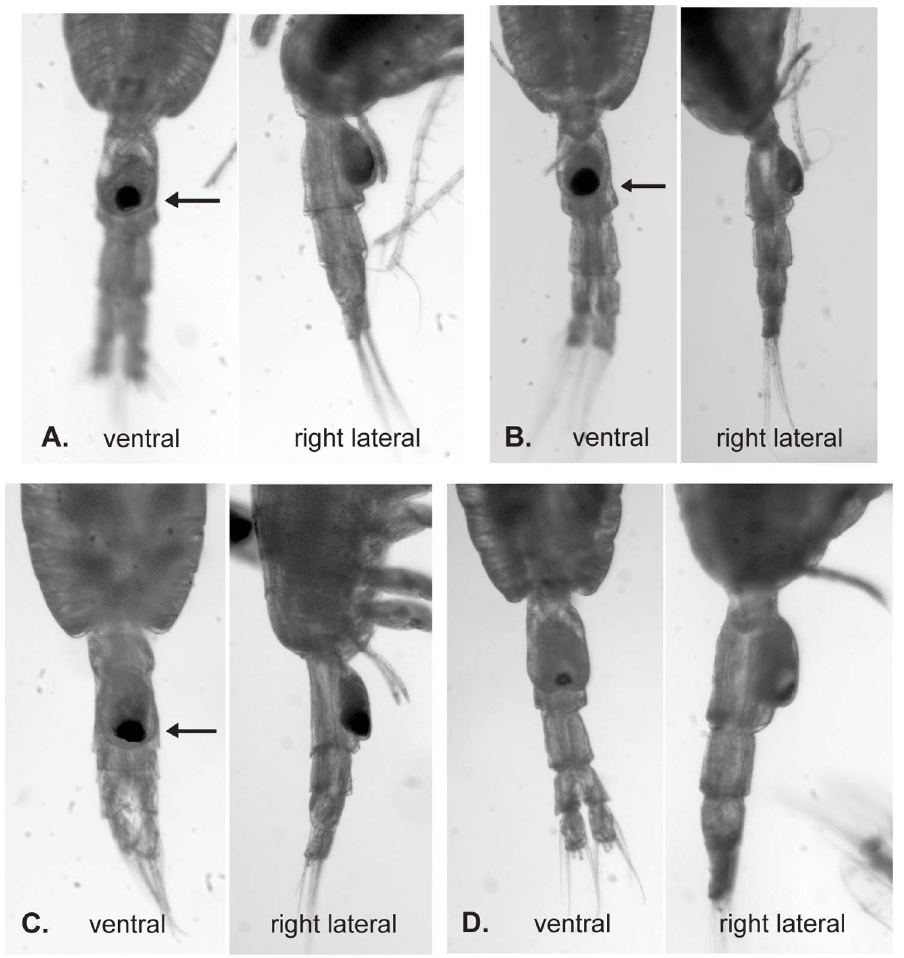
Figure 5. Digital images of the posterior prosome and urosome of P.piseki – P.gracilis animals from four genetic clades. Animals from (A) clade A, (B) clade C, (C) clade G, and (D) clade E are shown in ventral and right lateral views. By traditional morphological criteria, animals in (A), (B), and (C) would be identified as P. piseki and the animal in (D) would be identified as P. gracilis . Note that clade A and C both have a large black pigment spot at the copulatory pore, as well as a marked groove on the left side of the genital double-somite near the posterior margin (marked by an arrow), which was included in the original species description for P. piseki (Farran 1929). Clade G (panel C) also has a large black spot at the copulatory pore, but the spot is located at the posterior edge of the genital boss, and appears as a right-left oval rather than round in shape. Animals from this clade apparently lack the marked groove on the left side of the genital double-somite (absence visible at the black arrow). Finally, animals in clades E and B have genital characters that appear ‘gracilian’ ( P. gracilis -like), as shown in panel D on a clade E specimen.